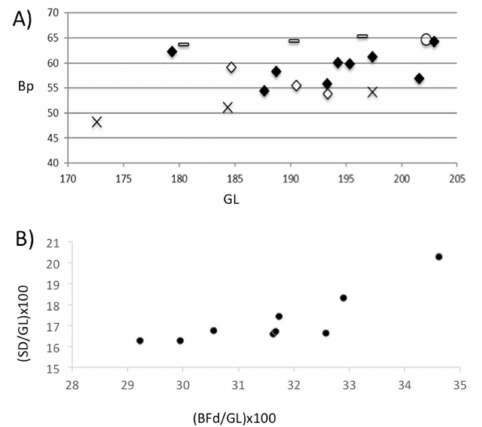
Figure 12. ( A ) Scatter diagram of GL (greatest length) and Bp (greatest width of the proximal epiphysis) measurements (in cm) of cattle from the Vilauba pit (black rhombus) and from other early Roman contexts in the villa (white rhombus), compared to three males (line), three females (cross), and one castrate (circle) from the Camargue cattle breed. ( B ) Scatter diagram of (BFd (distal width across both condiles)/GL (greatest length)) × 100 and (SD (minimum diaphysial width)/GL (greatest length)) × 100 indices of cattle from the Vilauba